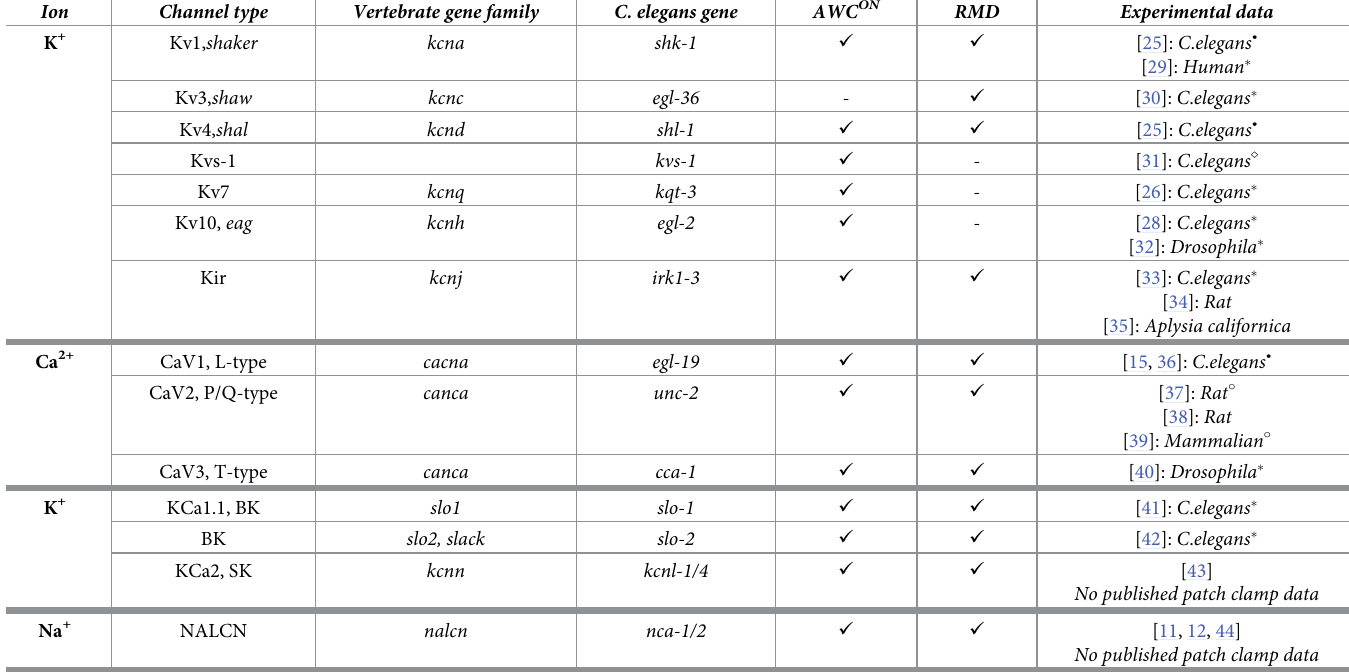
Table 1. List of modeled ion channels. The modeled C. elegans ion channels (second column), grouped on the basis of ion selectivity (first column) are classified according to vertebrate homologues (third column) and corresponding nematode genes (fourth column). The fifth and the sixth columns report the gene expression in AWC ON and RMD. The seventh column reports the references to experimental data used to model each channel type and the relative organism. The symbols denote the specific patch clamp recording conditions: • on dissected worm cultured myocytes [25], body wall muscles [15] or pharynx [36], � , � and � respectively on Xenopus oocytes, HEK cells, and CHO cells expressing the desired genes. In the text, the genes encoding for the modeled channels and the corresponding channel proteins are reported in italic and capital letters, respectively (e.g egl-19 genes encode for EGL-19 channels). Further, we denote the current associated to a specific class of channels with the channel